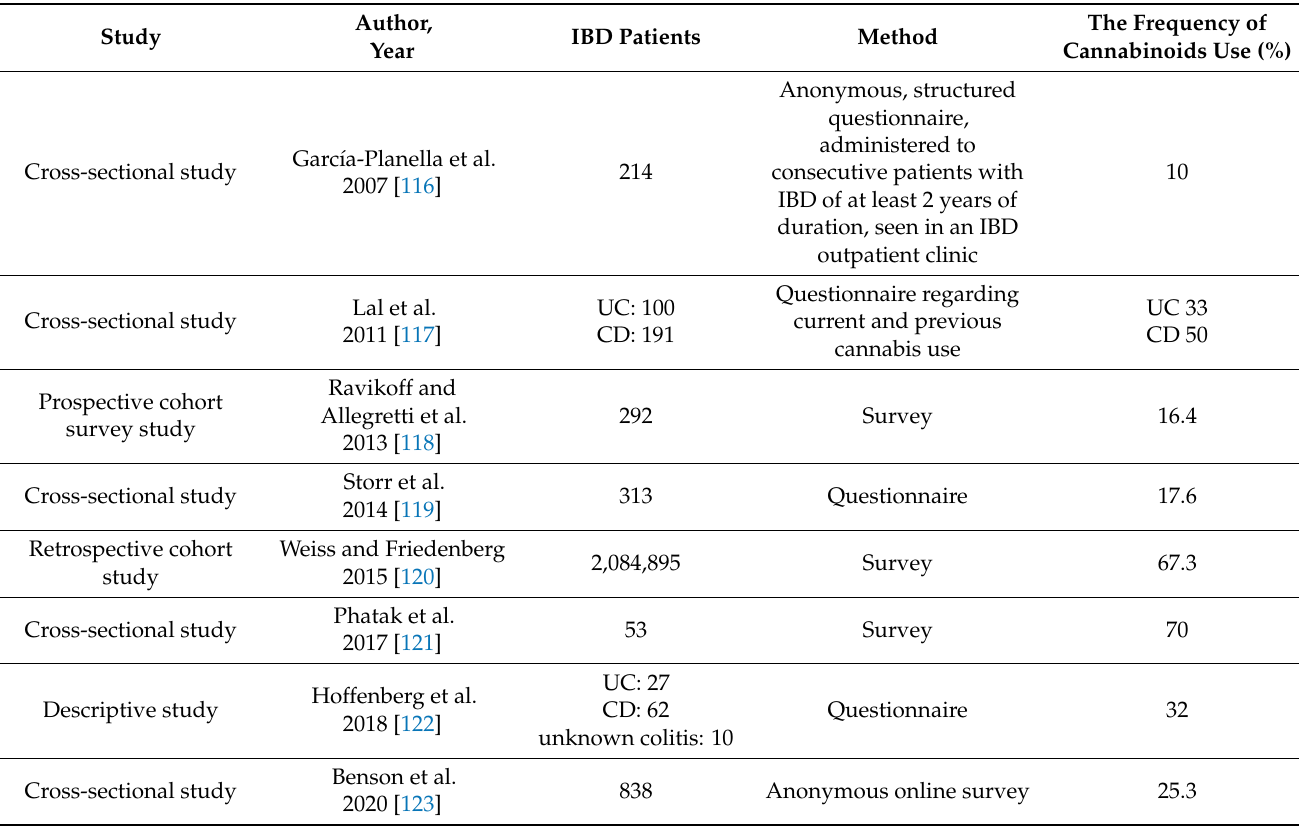
Table 6. The frequency of cannabinoids uses among inflammatory bowel disease